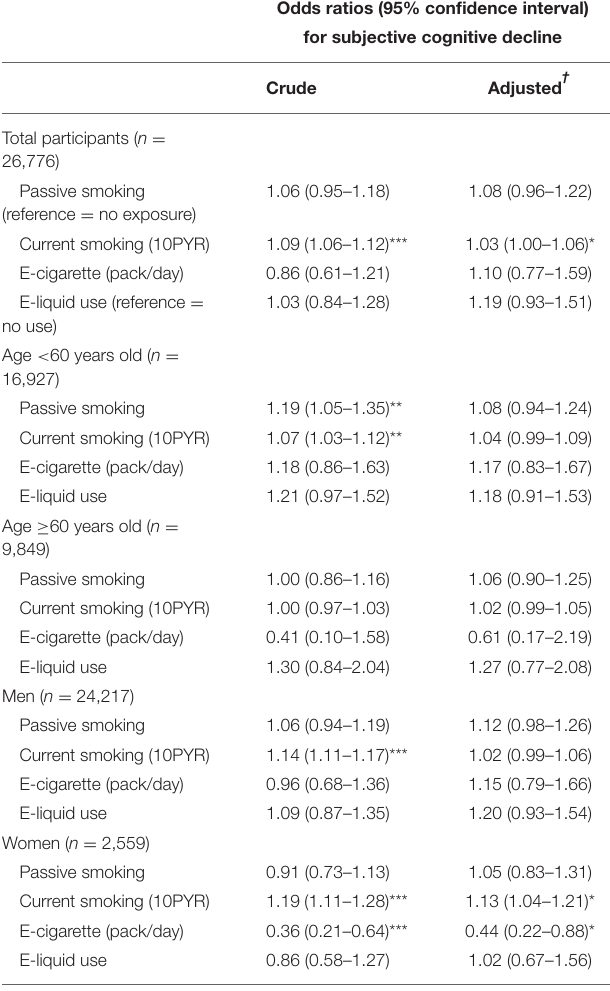
TABLE 5 | Crude and adjusted odds ratios and 95% confidence intervals for subjective cognitive decline according to passive smoking, E-cigarette, E-liquid use, and lifetime pack years among current